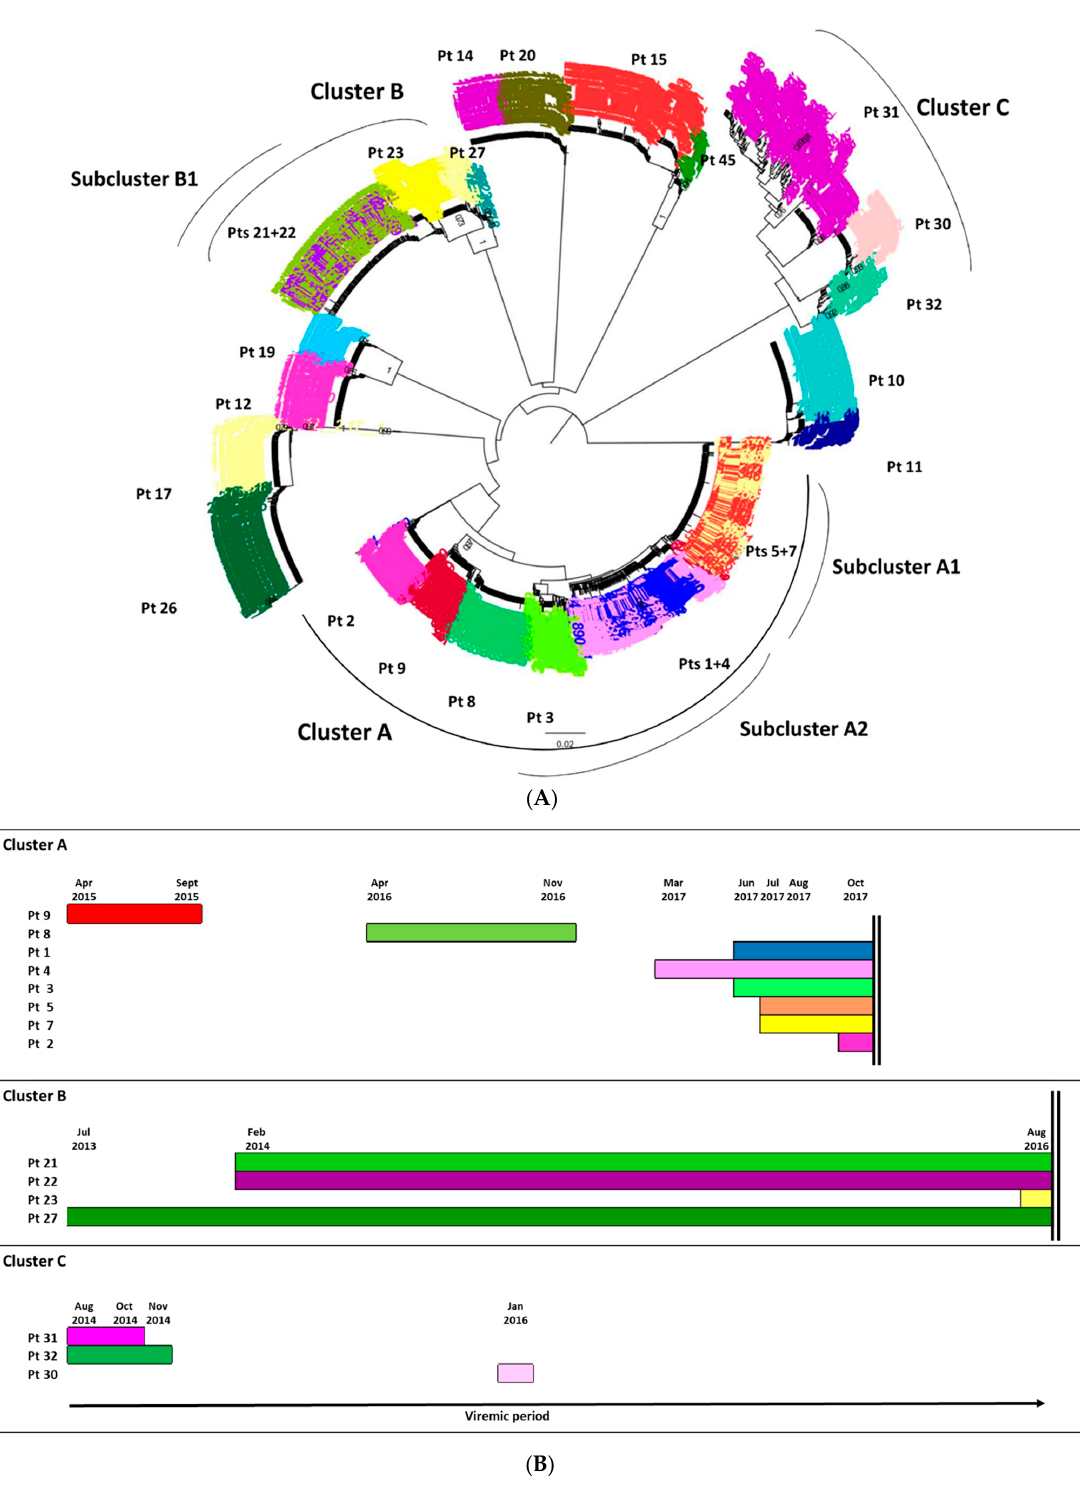
Figure 2. Phylogenetic tree constructed with ultra-deep env region sequences of subtype B infected subjects, previously included in TC by pol population sequencing with viremic period ( A ) Maximum likelihood phylogenetic tree constructed with all the representative env sequences obtained from subtype B subjects included in TC, corresponding to pol population sequences shown in Figure 1. ( B ) Viremic period of each patient included in the clusters A, B, and C starting from the diagnosis to a time in which all the included subjects displayed a detectable viremia. Each patient is represented with a different color and Pt numbers are the same of Figure 1.